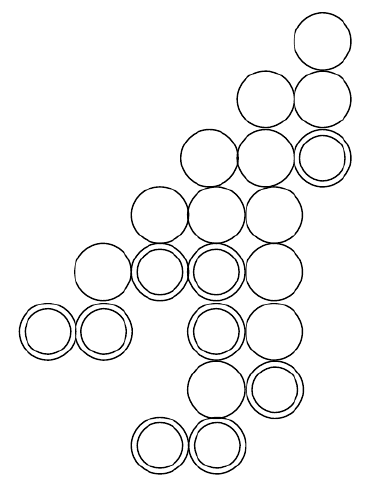
Figure 8. Example of a